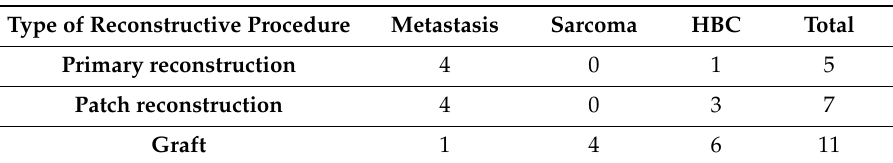
Table 3. The number of patients receiving a specific type of ICV reconstruction by oncological indication. In the HBC and the sarcoma groups, the reconstruction by means of a graft prevails, whereas patients with metastases were less likely to receive a graft.